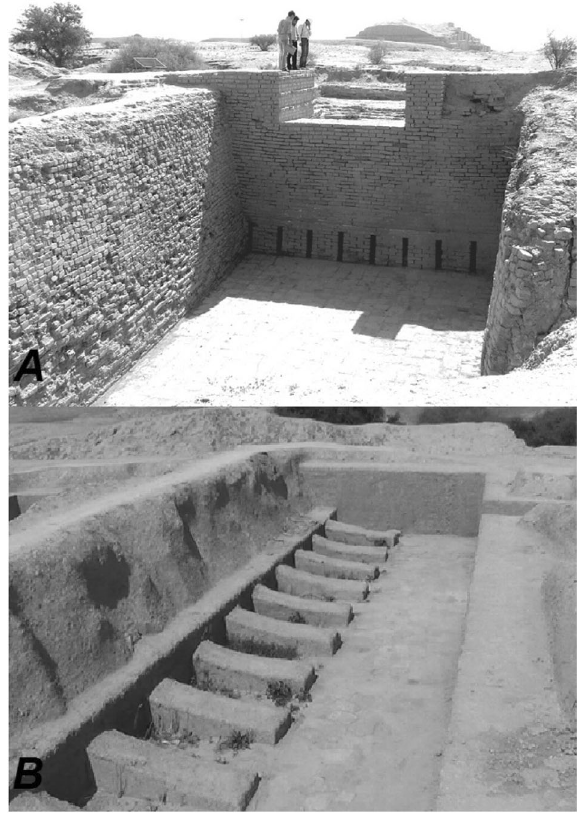
Fig. 2 The remaining of a water treatment system in “ Chogha Zanbil ” Complex, Khuzestan, Iran. a Front side view: Water was stored and desilted in the reservoir with a capacity of 337m 3 (10.70m×7.25m×4.35m). b Back side view: The fi ltered water was transferred to a pond through nine conduits. When the pond was fully recharged, the fi ltered water was distributed by a network of canals (Adopted from Naghsh Avaran Toos Consulting Engineers Company,